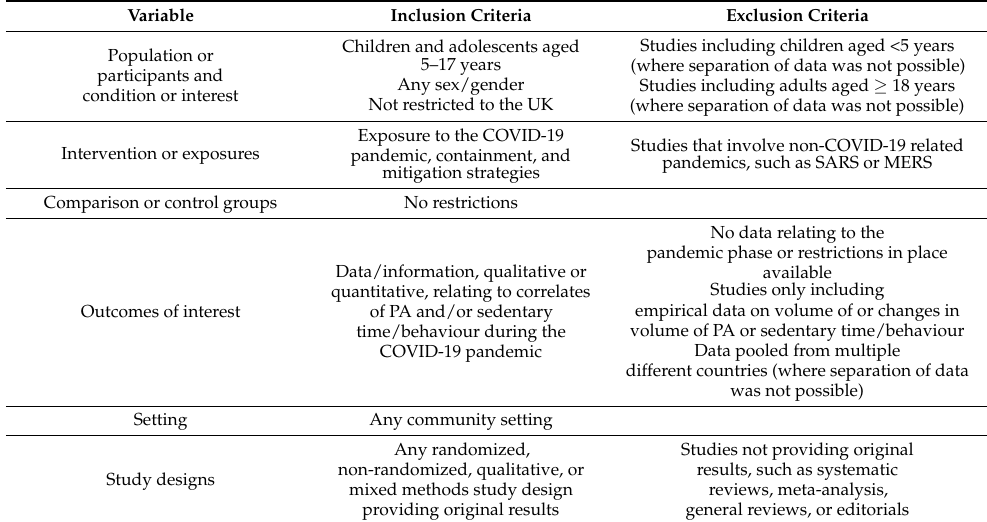
Table 1. Study inclusion/exclusion